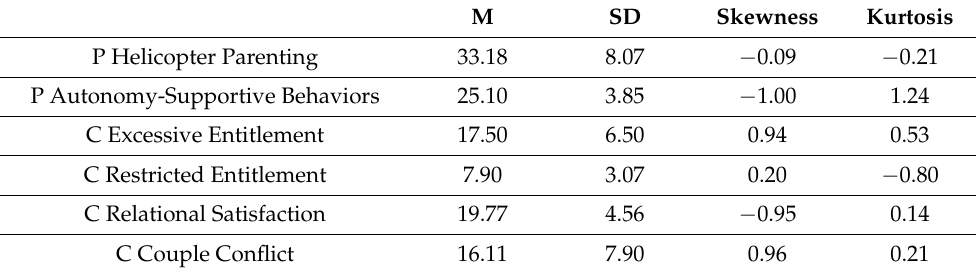
Table 1. Summary statistics for the variables included in the